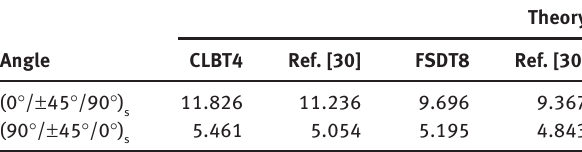
Table 4 Comparison of non-dimensionalized natural frequencies of a simply supported symmetric angle-ply composite beam with = 25; L / h = 10). / E material II ( E 1 2